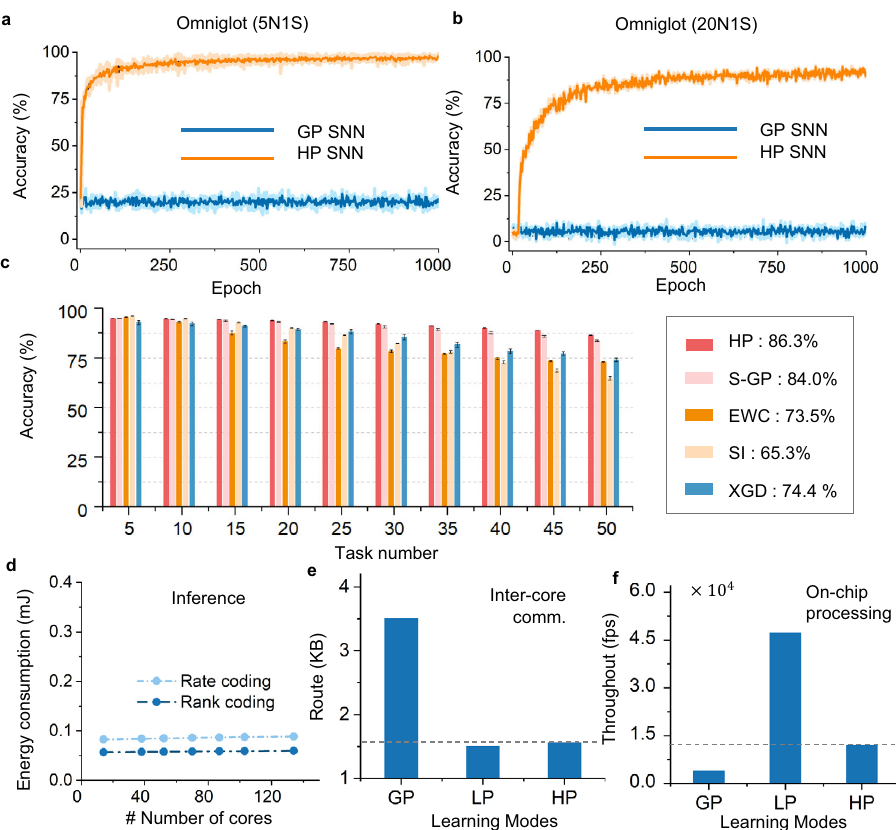
Fig. 5 Performance evaluations of hybrid plasticity spiking neural networks. a , b Performance curves on the Omniglot dataset with fi ve-way, one-shot (5N1S, a ) and twenty-way, one-shot (20N1S, b ) experiments. The average and standard deviation over fi ve runs for each epoch are reported. c Histogram of the accuracy of different techniques using the shuf fl e-MNIST dataset. The right side shows the average performance of over 50 tasks. The sparsi fi cation-weight learning is called by the S-GP for short. The error bar is given by the standard deviation over fi ve runs. Note that all models are based on spiking leaky integrate-and- fi re neurons and slightly differ from that in other published work. d The HP model can support multiple spike coding schemes on the Tianjic and achieve highly ef fi cient inference. Critically, the energy consumption increases slowly as the network size expands owing to the spike-based paradigm and local-memory structure. e The comparison of inter-core communication resources in three different learning modes. f The throughput evaluation of on-chip learning in three different learning modes. Details of hardware evaluation methods are described in the Methods.